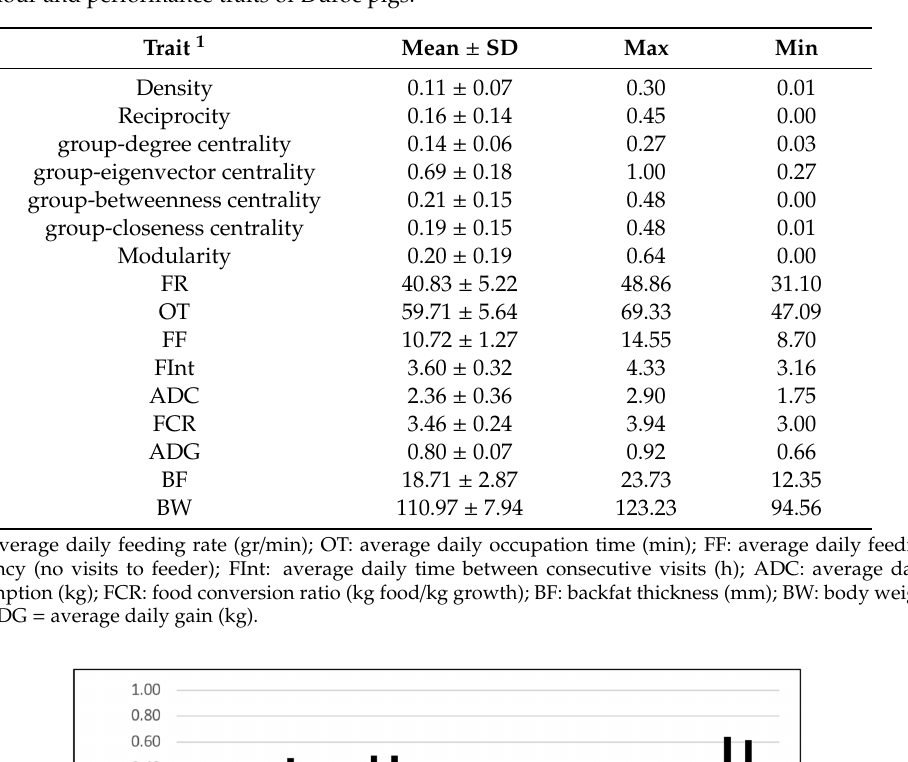
Table 6. Descriptive statistics for social network group measures and average pen values for feeding behaviour and performance traits of Duroc pigs.